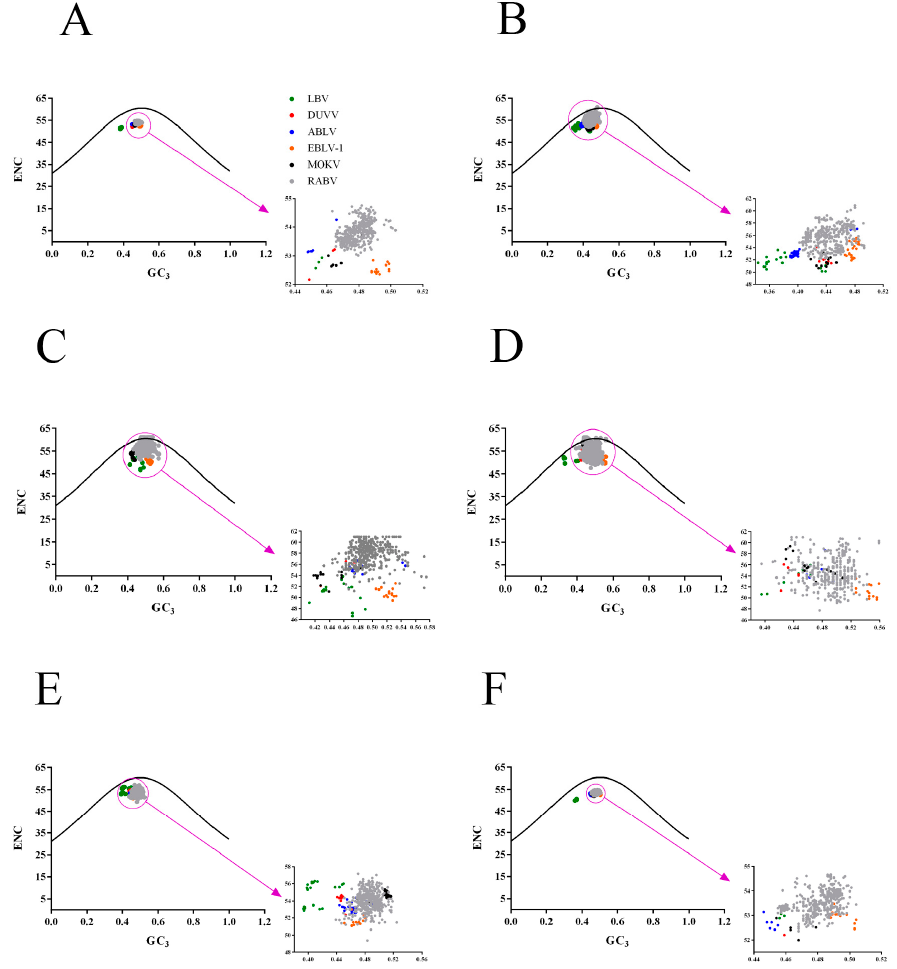
Figure 3. ENC-GC 3 plot. ( A ) Whole genome; ( B ) N; ( C ) P; ( D ) M; ( E ) G; ( F ) L. The color coding is the same as that of ( A ).